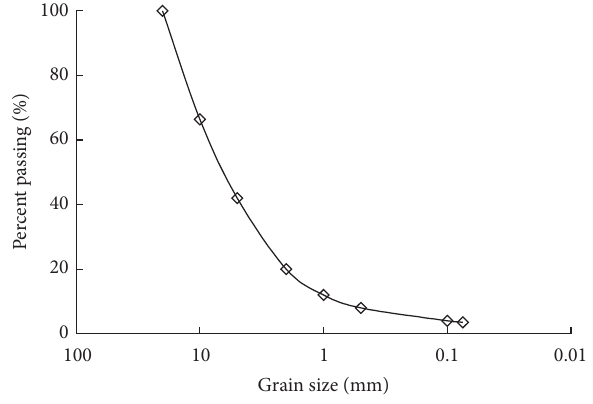
Figure 1: Grain size distribution of